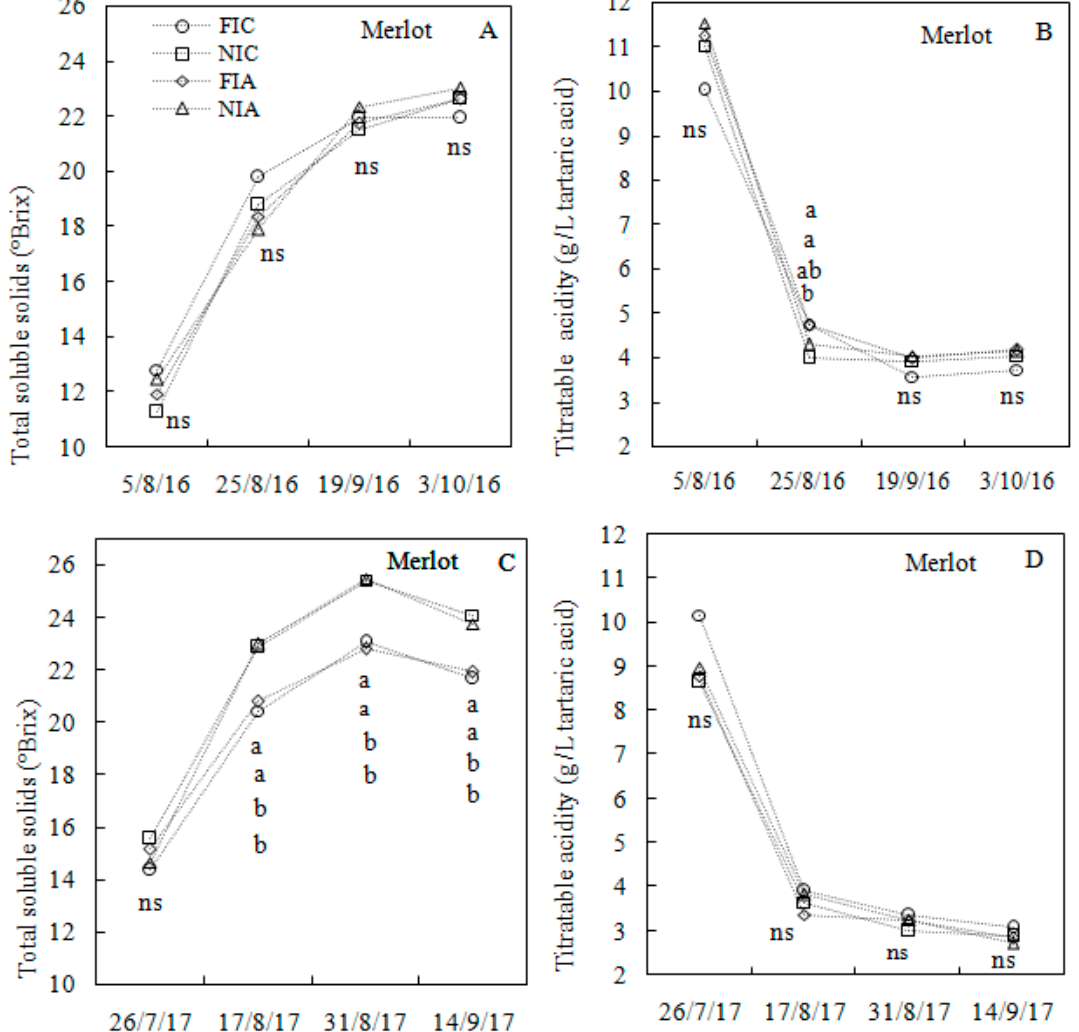
Figure 2. Seasonal variations of grape total soluble solids in 2016 ( A ) and 2017 ( C ) and titratable acidity in 2016 ( B ) and 2017 ( D ) in cv. ‘Merlot’. FIA = full irrigation ( + ) ABA; FIC = full irrigation ( − ) ABA; NIA = no irrigation ( + ) ABA; NIC = no irrigation ( − ) ABA. The di ff erent letters indicate statistical significance at P ≤ 0.05 using the LSD test. ns = not significant.